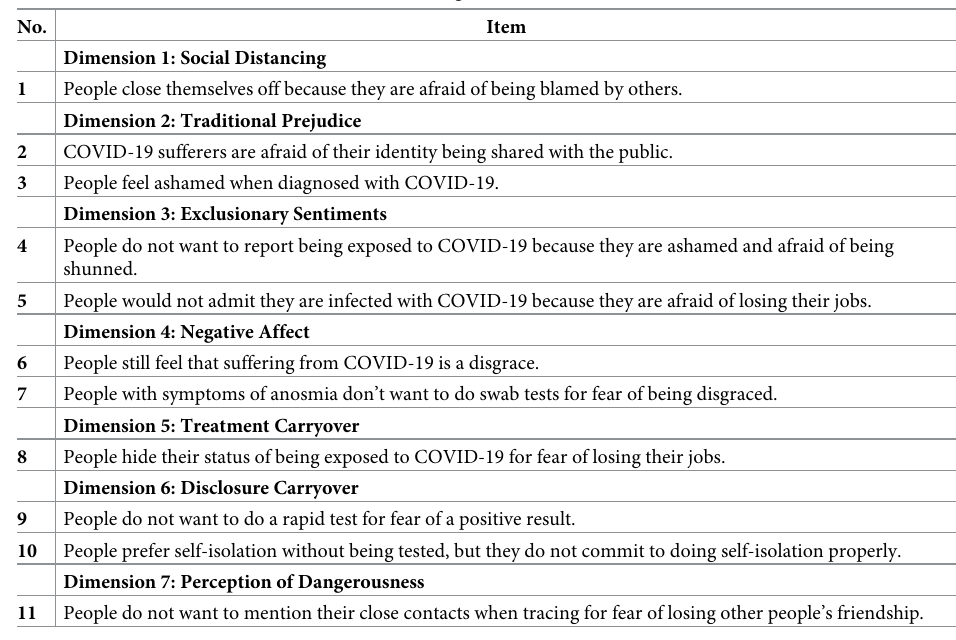
Table 3. The seven-dimensional COVID-19 social stigma